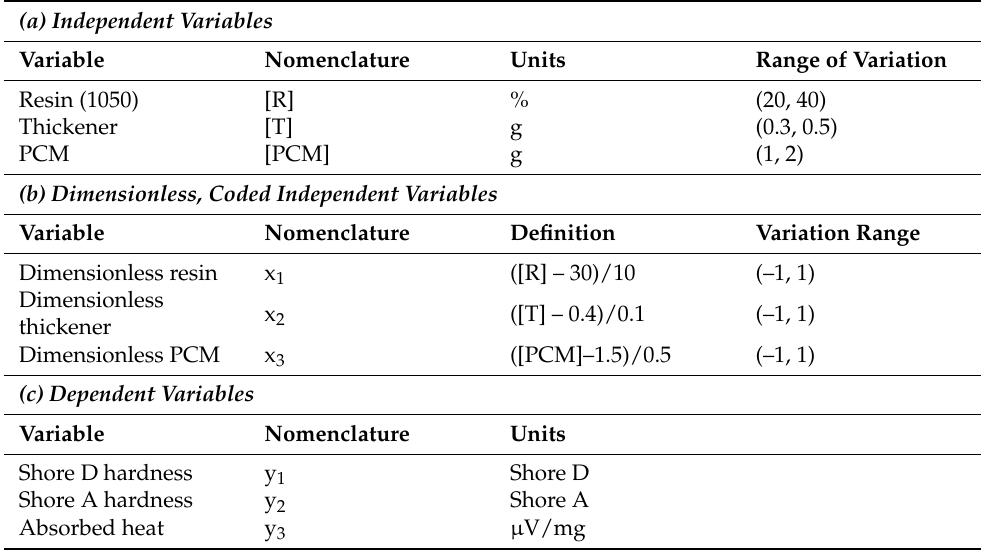
Table 2. Independent and dependent variables used in the